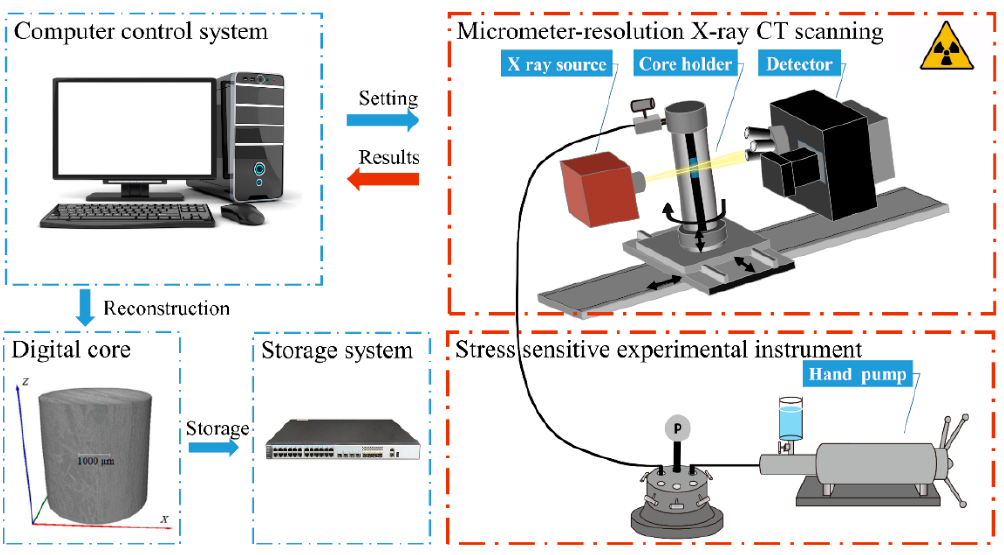
Figure 2. Schematic diagram of in situ X-ray CT characterization system of cyclic stress sensitivity.